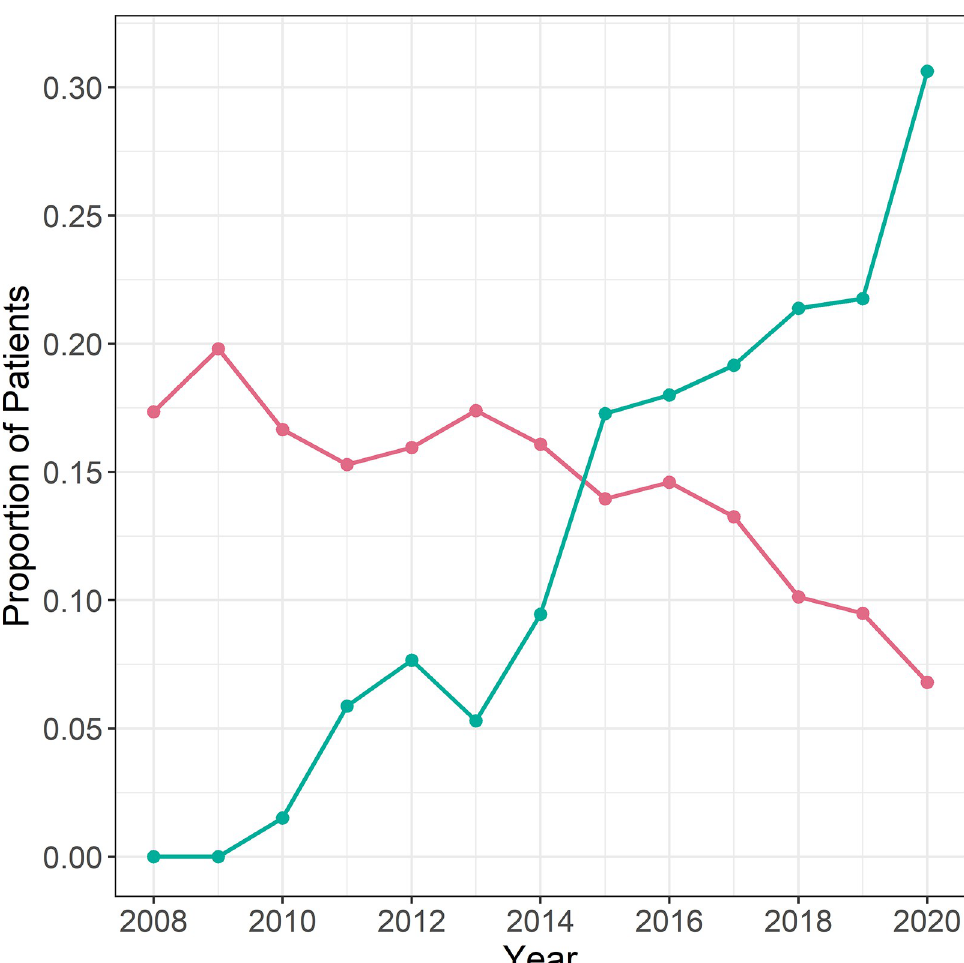
Fig 4. Purchase of first- (red) and second-generation (turquoise) supraglottic airway devices over time (records of the internal hospital